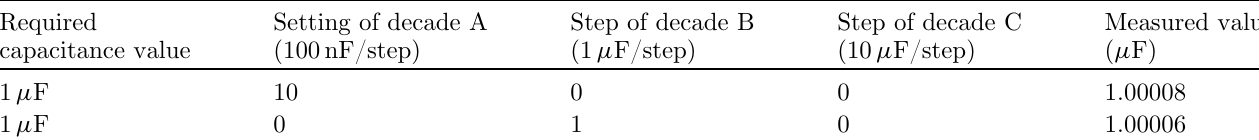
Table 2. Different possible combinations to generate 1 m